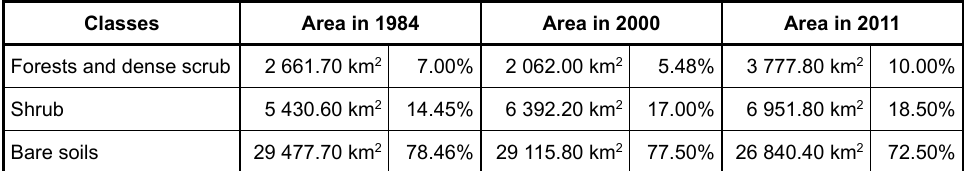
Table 2. Evolution of forest area Classes